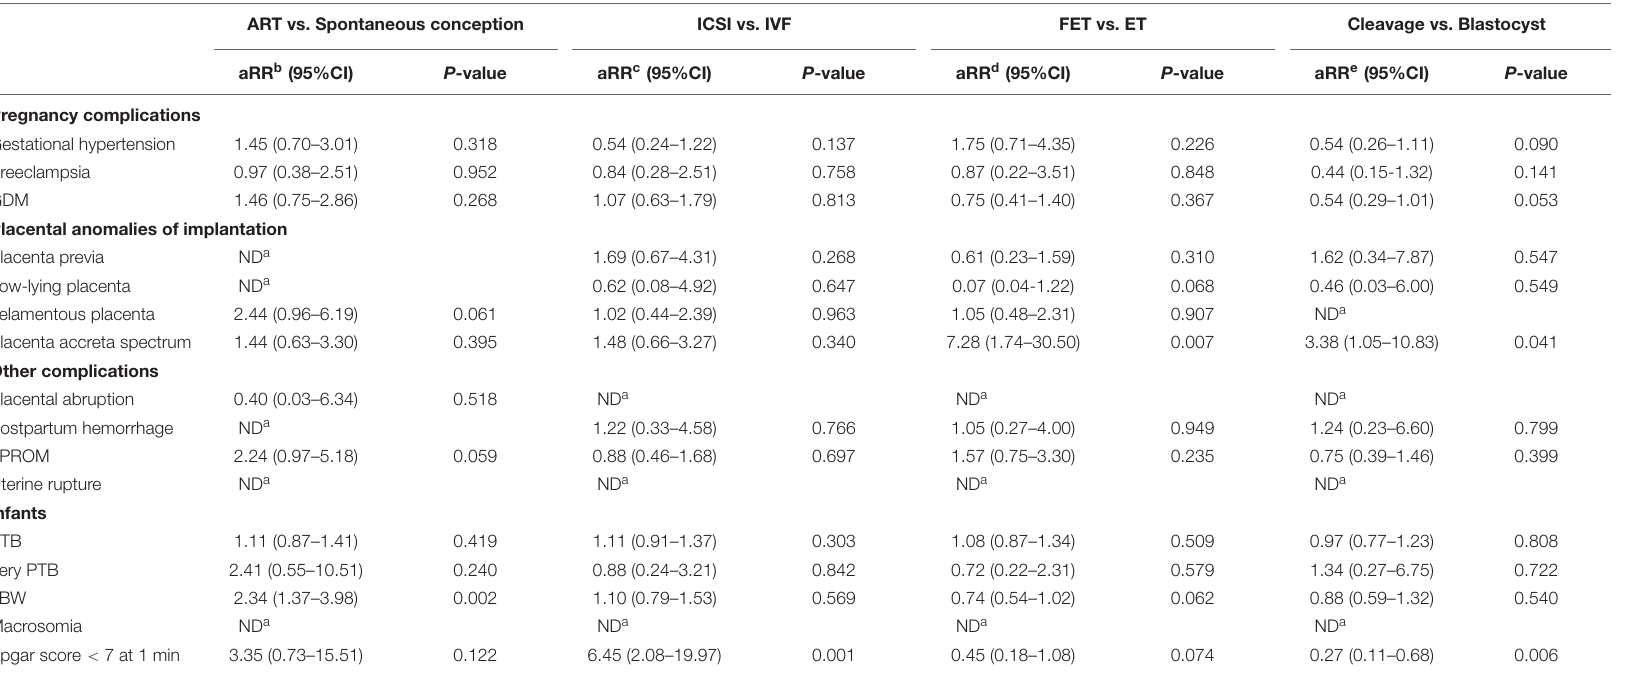
TABLE 6 | The effect of ART procedures on obstetric and perinatal outcomes of twins in women with previous